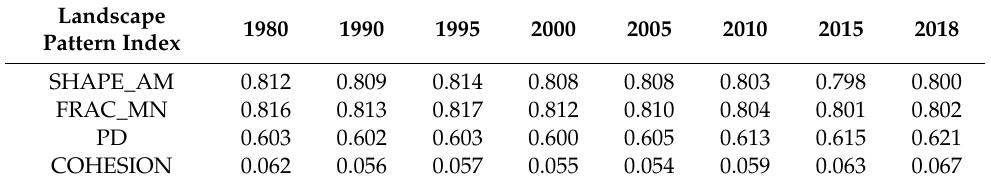
Table 3. Correlation of landscape pattern index between class and landscape level.